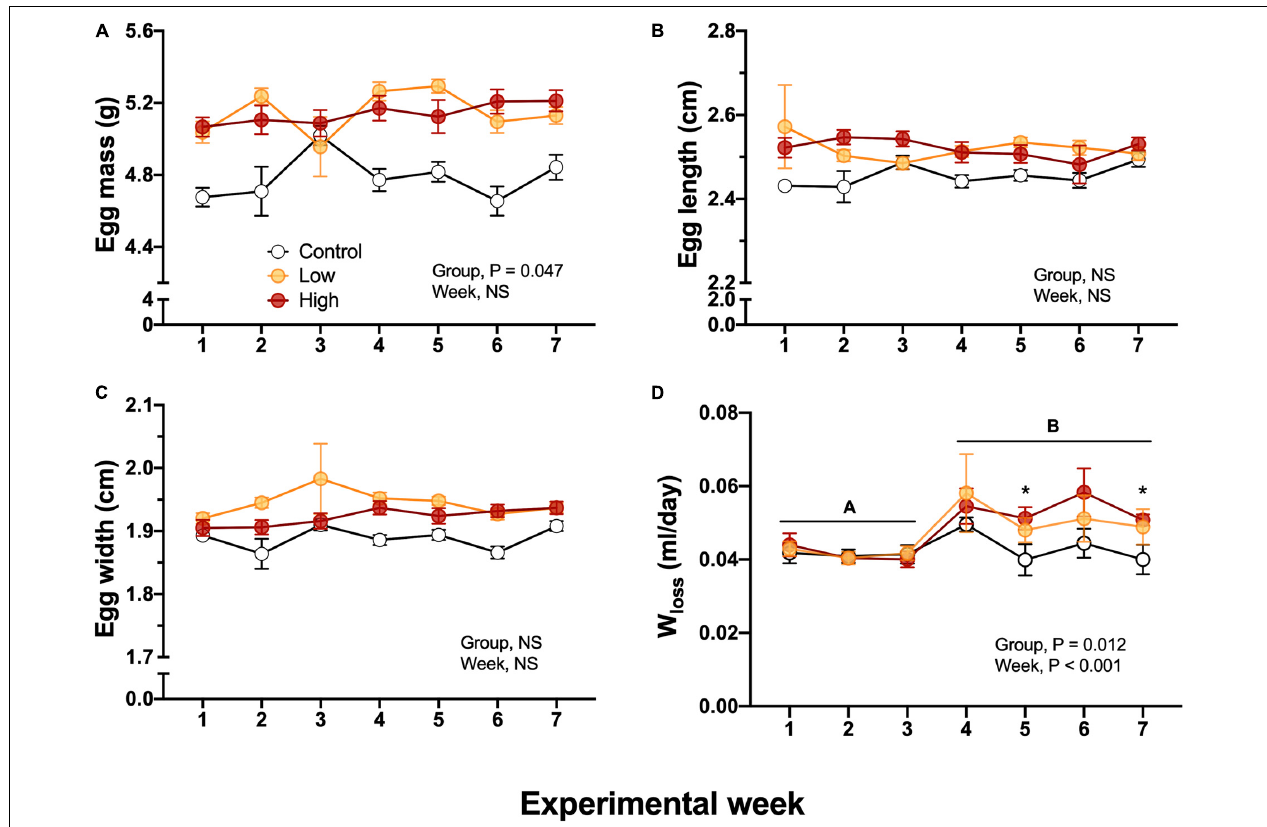
FIGURE 4 | Metrics and water loss in F 1 eggs obtained from of king quail. (A) Egg mass (g), (B) Egg length (cm), (C) Egg width (cm), and (D) Water loss. Data is expressed as mean ± 1 standard error of the mean. Statistical significance was considered with α = 0.05. Different letters indicate statistical differences between weeks. “*” Indicate statistically significant differences between groups at the specific experimental weeks. n = 6–29 per data